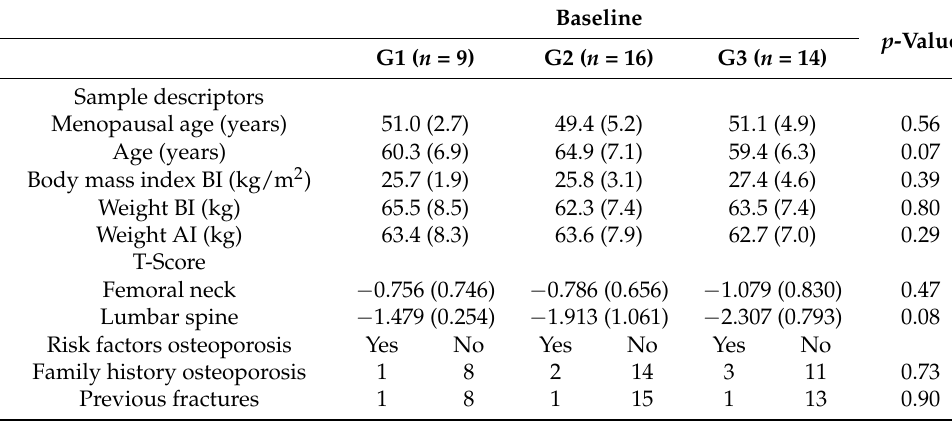
Table 1. Baseline characteristics of the study